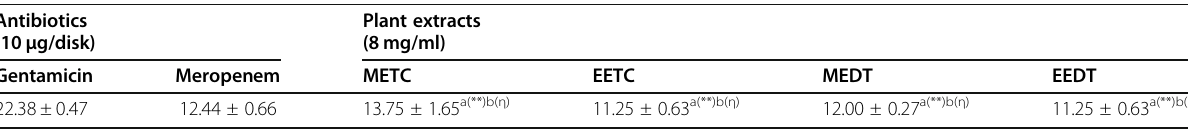
Table 3 Antimicrobial screening test of ethanolic and methanolic extracts of different plants (8 mg/ml, 40 μ l/disk) against Vibrio. cholerae Antibiotics (10 μ g/disk)